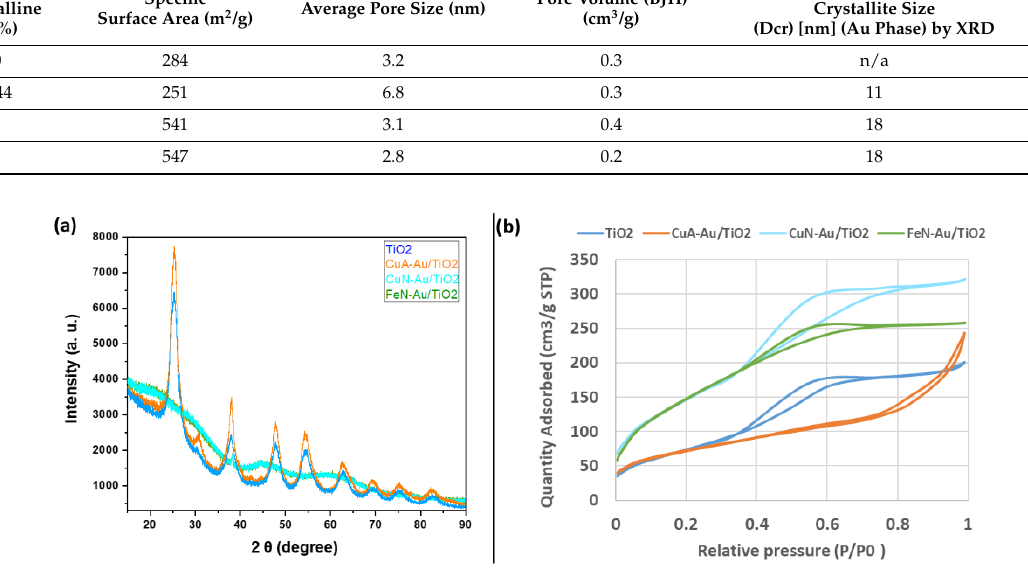
Figure 2. Photocatalytic activity of sol – gel-synthesized bimetallic TiO 2 in the batch system ( a ) and microflow system ( b ) after 60 min of the photocatalytic experiment with 1 mM BnOH under UV light.